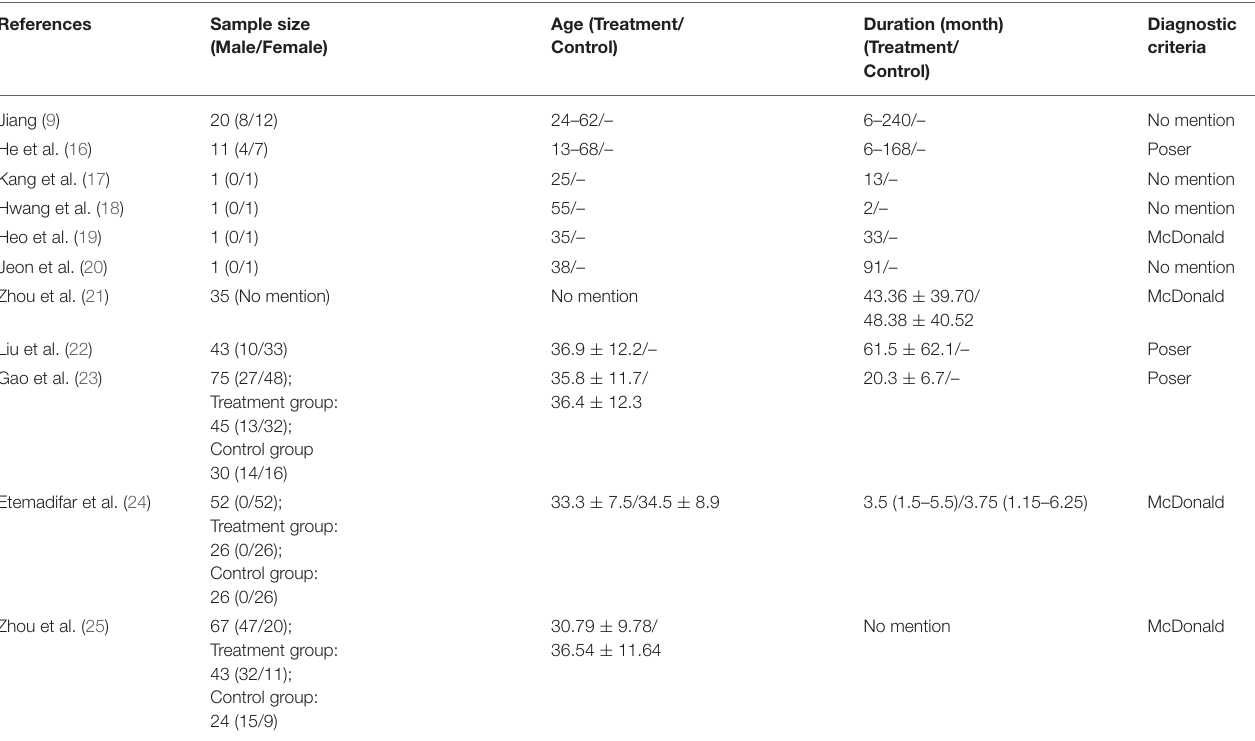
TABLE 2 | Demographic and clinical characteristics of